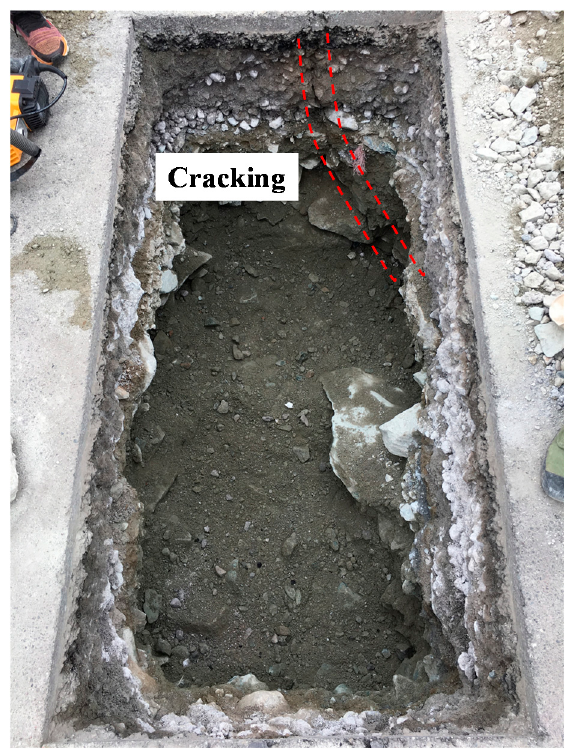
Figure 4. The revealed cracks in exploratory pits.